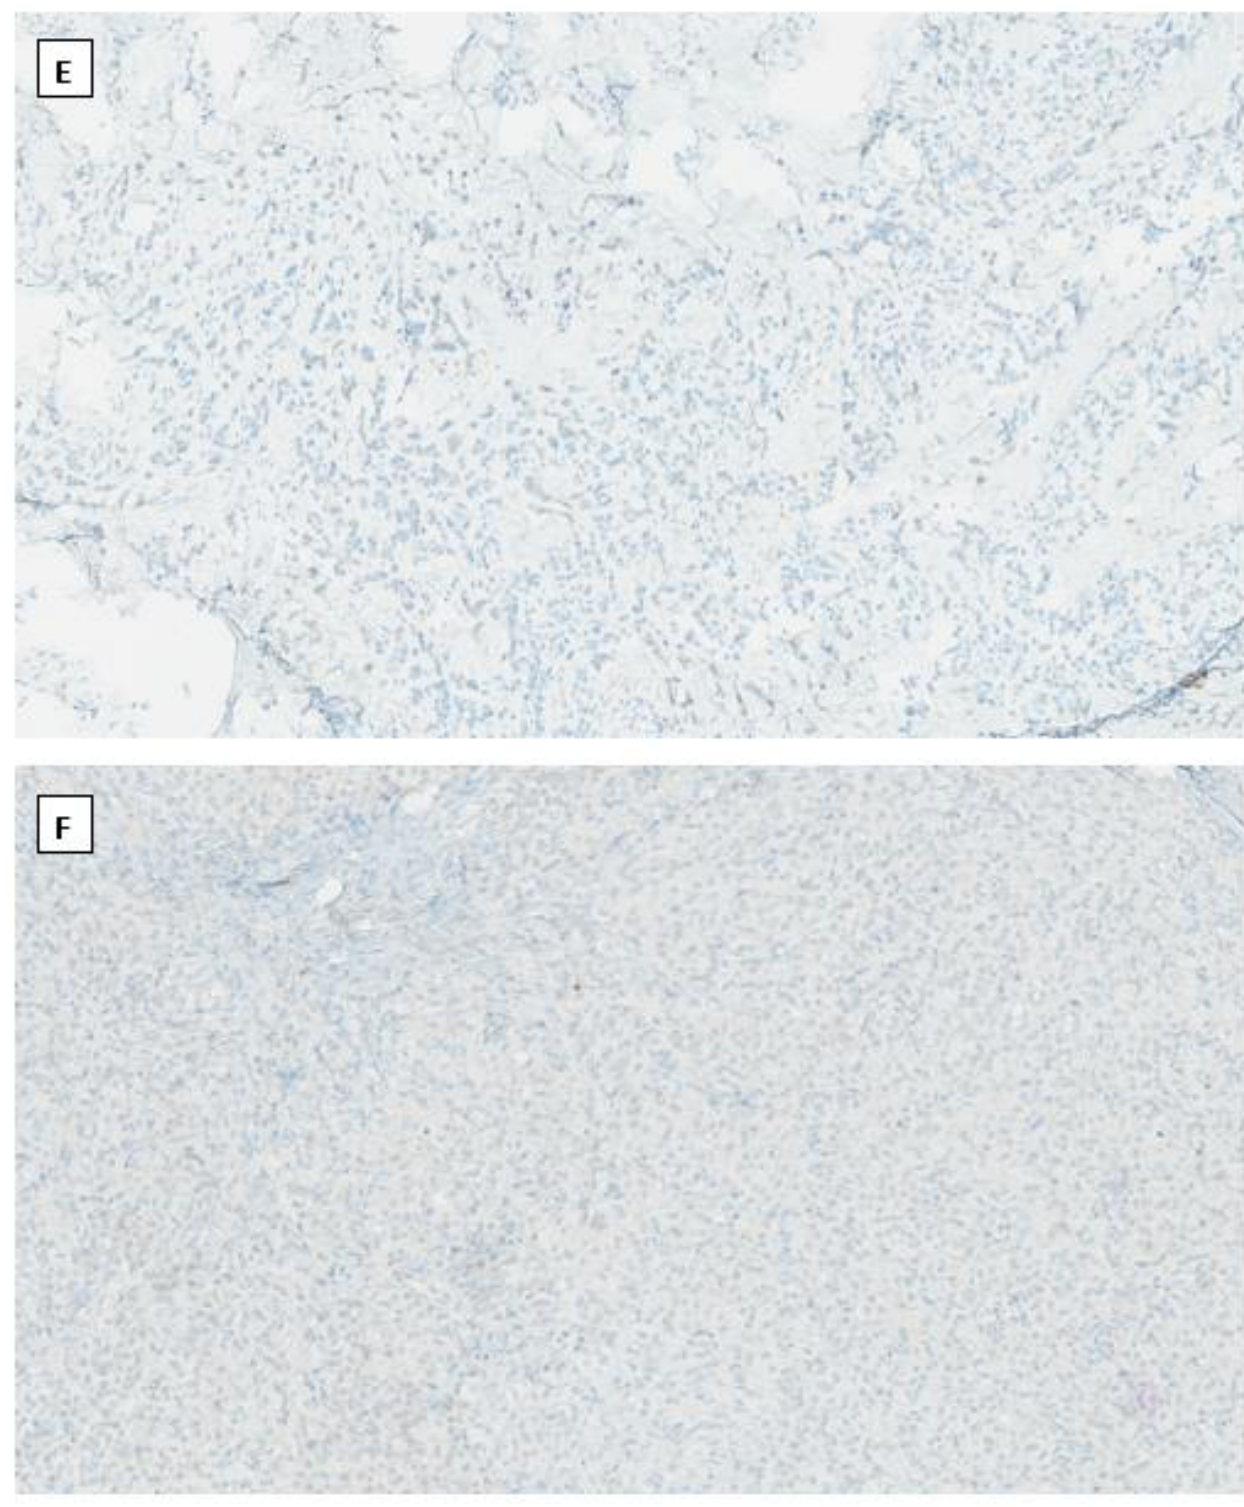
Figure 2. Microcystic stromal tumor of the ovary. Tumor cells grow in delicate cords or solid sheets with blend cytology in a background of extensive hyalinized stromal fibrosis (H&E stain at 20× magnification for ( A ) and 200× magnification for ( B )). Immunohistochemical staining demonstrates intense nuclear and cytoplasmic staining of Beta-catenin ( C ), intense nuclear with weak cytoplasmic staining of LEF-1 ( D ), and negative staining for SF1 ( E ) and inhibin ( F ). Immunostaining for β -catenin is at 200×, and for LEF-1, SF1 and inhibin are at 100× magnifications, respectively.